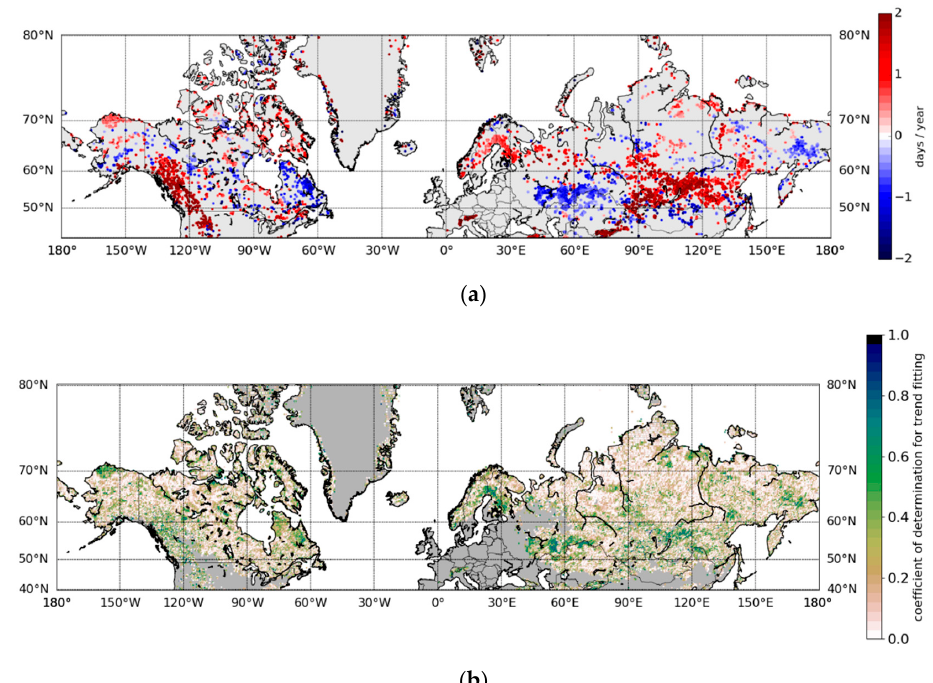
Figure 10. ( a ) The rates of change for the length of melt season between 1982 and 2015 using 5-year rolling mean (showing cases for which R 2 of the fit was larger than 0.5). The negative rates of change mean shorter melt seasons and the positive rates of change mean longer melt season. ( b ) The coefficient of determination ( R 2 ) values for the trend fitting for length of melt season.